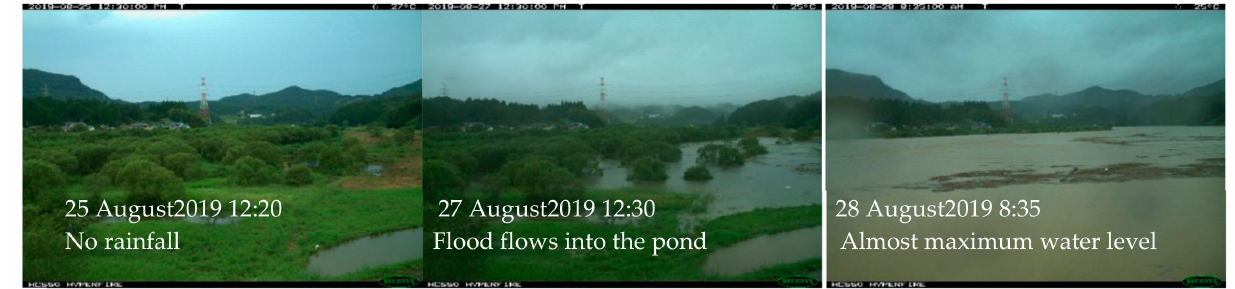
Figure 9. Azame-no-se in different stages, from immediately before the flood to the maximum water level.